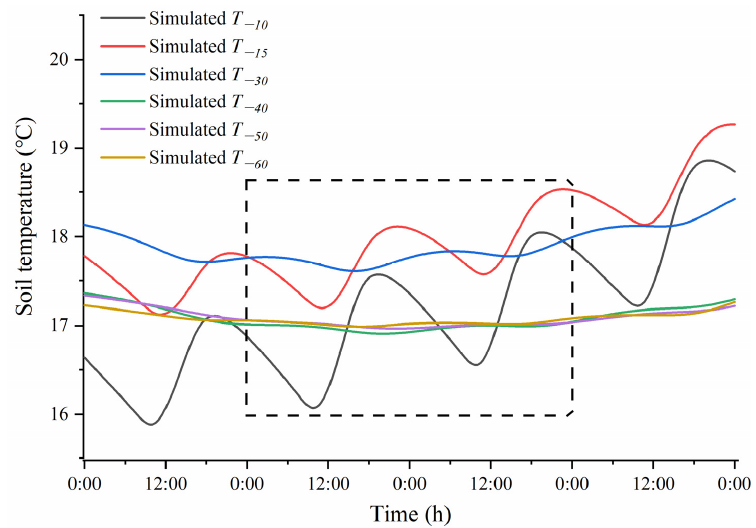
Figure 21. Soil temperature distribution at 16:00 on 27 December 2019. ( a ) Z = − 15 m, ( b ) Z = − 50 m, and ( c ) X = 0.3 m (the X-to-Y ratio is set as 20). The simulated soil temperatures at different depths on typical sunny winter days are shown in Figure 22. The hysteresis and attenuation of soil temperature fluctuation increases with depth. Solar radiation and air temperature have great impacts on shallow soil at depths of 10 cm and 15 cm, but little impact on the soil at 30 cm and almost no impact on the soil at depths from 40 to 60 cm. Since no auxiliary heat sources are set up in the greenhouse, the shallow soil on the surface releases heat to the air in the greenhouse at night. Therefore, the soil temperatures at depths of 10 cm are lower than those at 15 cm, and the temperature difference decreases when the air temperature increases.